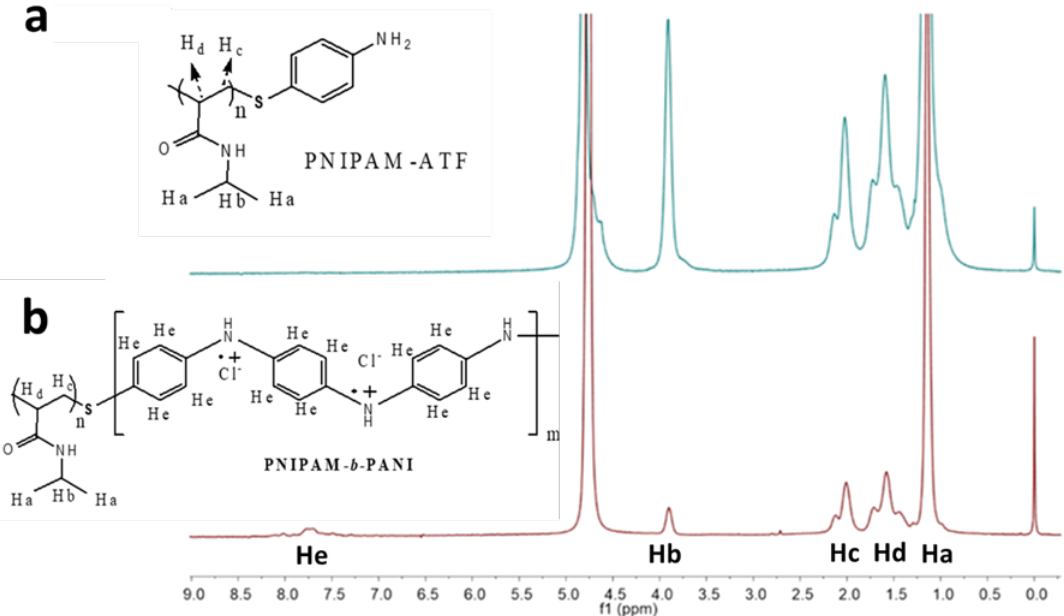
Figure 3. 1 H nuclear magnetic resonance (NMR) spectra: ( a ) PNIPAM-ATF and ( b ) PNIPAM- b -PANI.